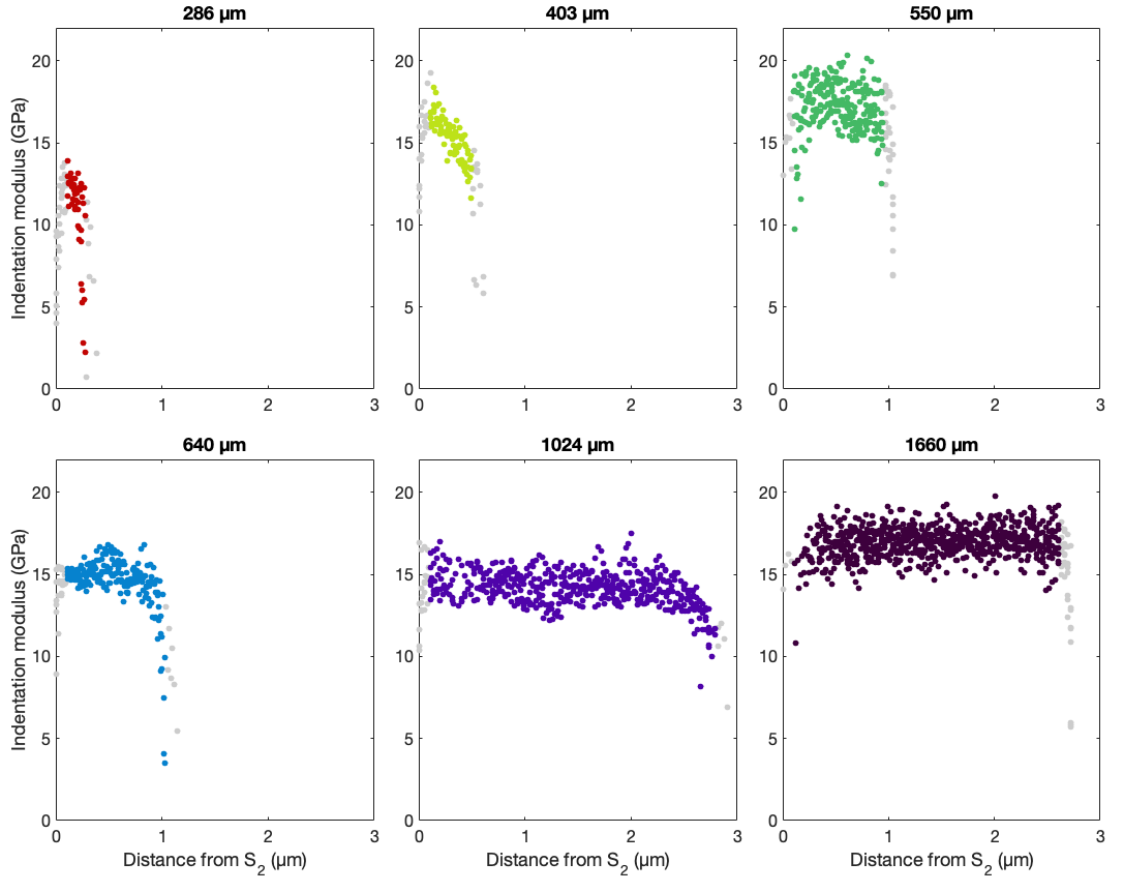
Figure 5 : Observation of the occurrence of a radial mechanical gradient during the maturation of the G- layer obtained by extracting radial profiles all around the cell axis in this layer and plotting them as a function of the distance from the S 2 layer, for fibres at six different distances from the cambium (value given at the top of each graph). The first and last 100 nm were removed from each profile (data points in grey) to avoid any bias due to possible measurement edge